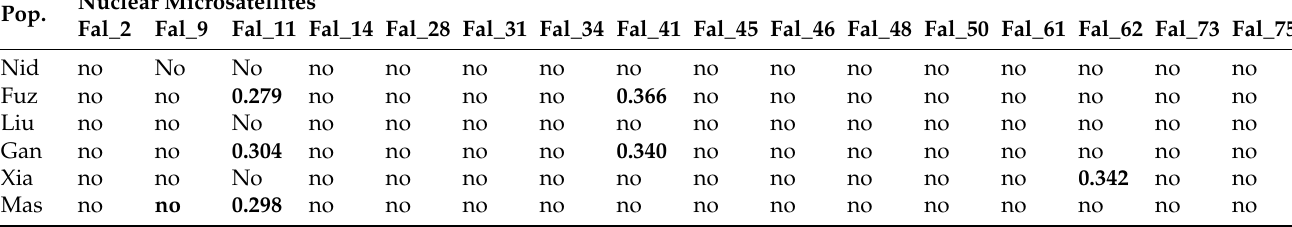
Table A2. Null allele frequencies for each locus at each population with more than three individual samples. Nuclear Pop.